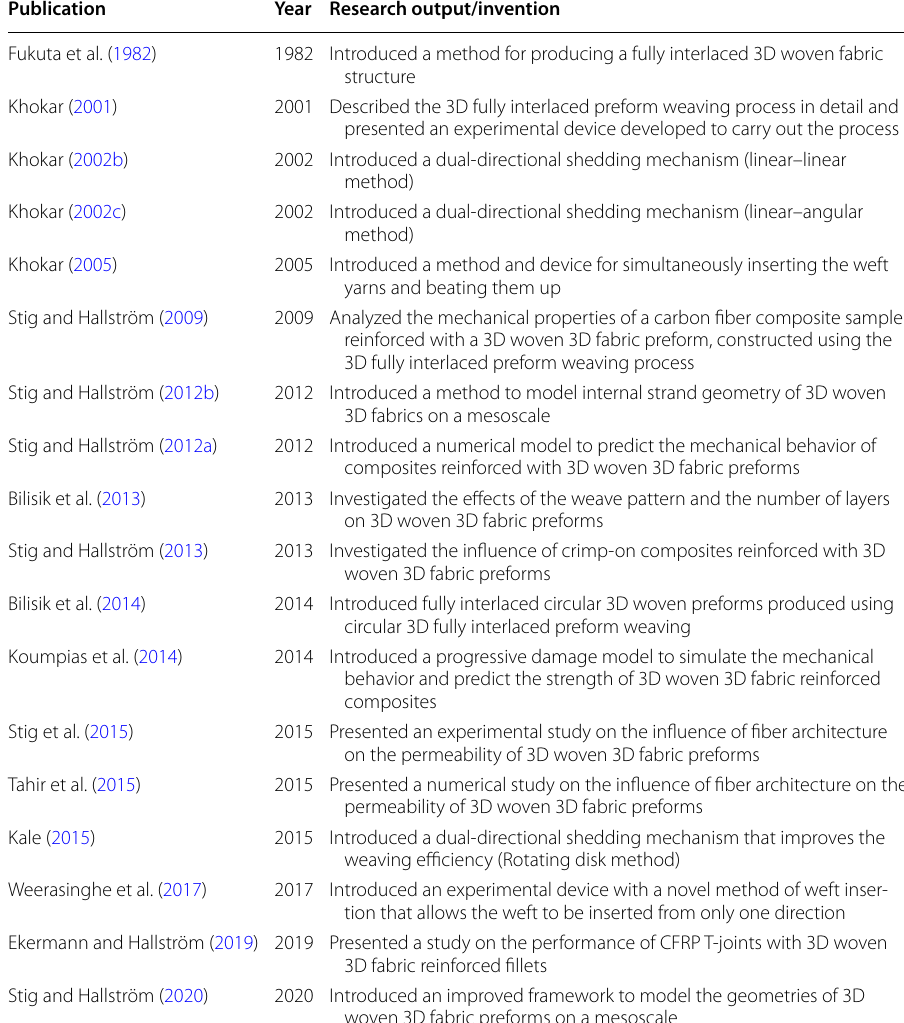
Table 1 Summary of the existing literature reviewed in the